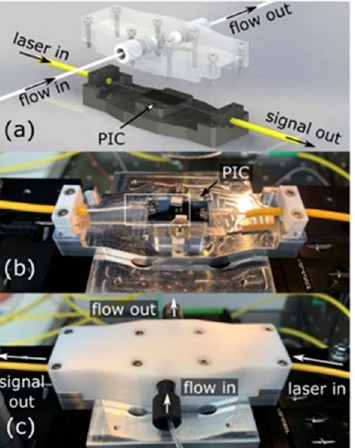
Figure 5. (Reprinted with permission from [54] © Optica) Fiber-packaged, microfluidic-coupled WERS. ( a ) Rendering of the assembly with optical fibers affixed to the chip and a flow cell that lowers onto the chip surface. ( b ) Photograph of the packaged chip with fibers glued to the edge. ( c ) The packaged chip with the flow cell secured on the top.